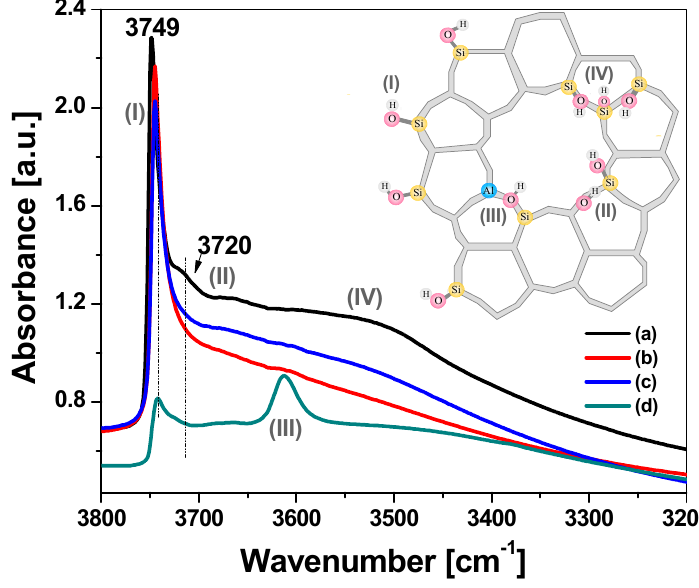
Figure 2. Fourier transform infra-red (FT-IR) spectra for studied materials ( a ) MFI-40; ( b ) MFI-45; ( c ) MFI-50 and ( d ) Zeolyst.